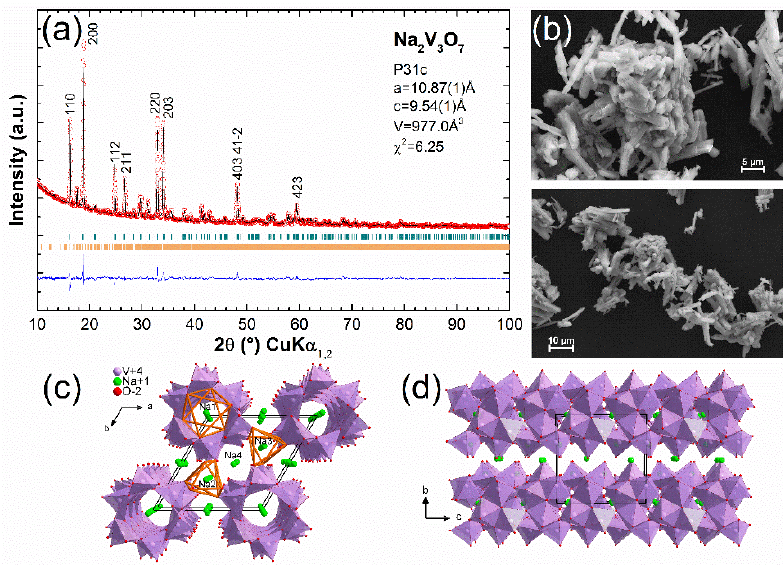
Figure 1. ( a ) XRD pattern and Rietveld fit for Na 2 V 3 O 7 in cyan and η -Na 1.286 V 2 O 5 in orange and ( b ) SEM images of the as-prepared material. Structural views ( c ) along c axis and ( d ) along a axis.